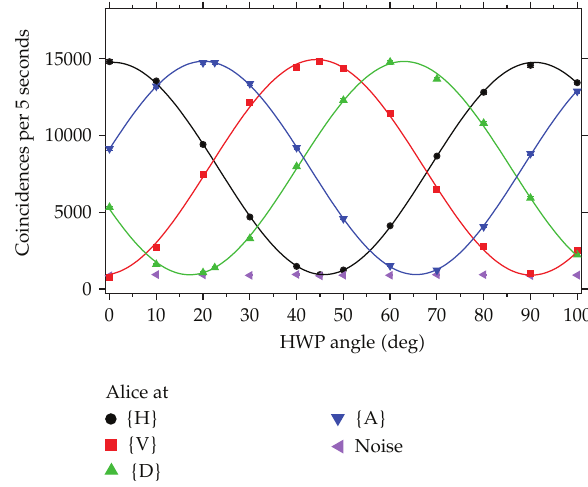
Figure 5: Bell state measurement results.